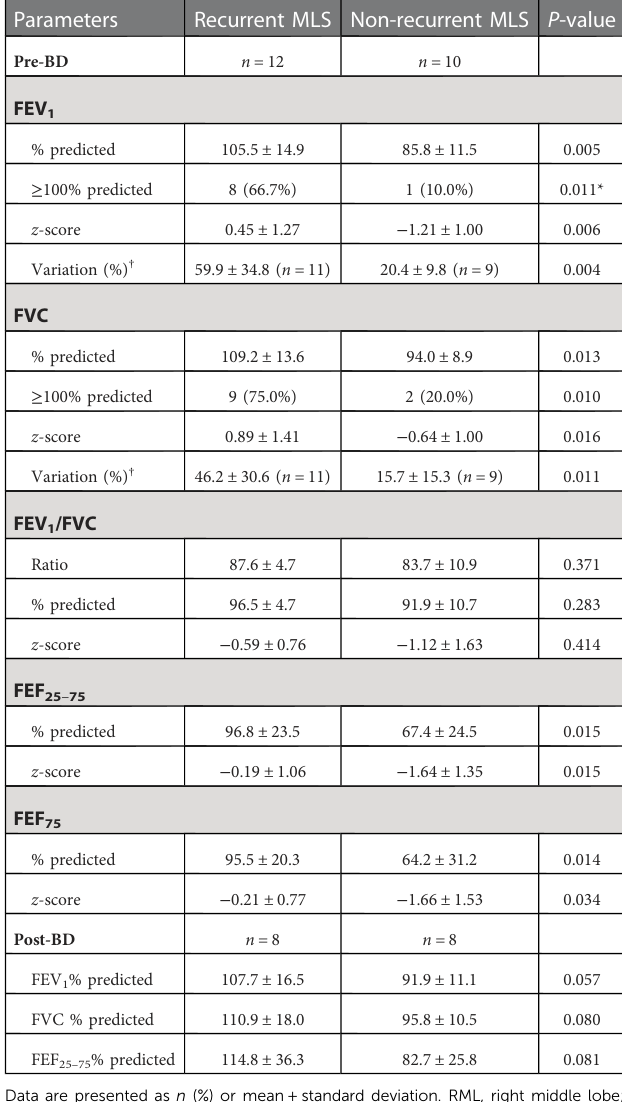
TABLE 3 Bronchoscopy fi ndings of asthmatic children with RML and/or lingula atelectasis strati fi ed by recurrent MLS. Characteristics